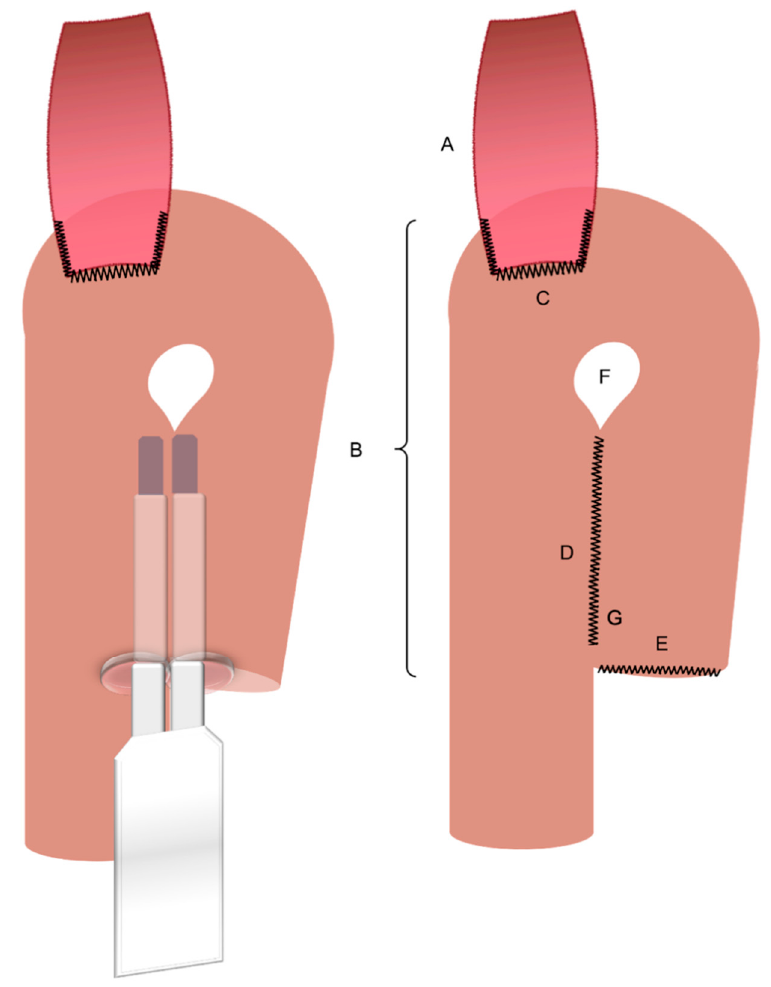
Figure 5. Jejunal pouch reconstruction—model; A. Esophagus. B. Jejunal pouch (~15 cm). C. Esophagojejunostomy (modified collard anastomosis). D. Jejunal plication. E. Jejunal stump. F. Intentional incomplete stapling of the jejunal plication. G. Barbed suturing of the stapler insertion area.